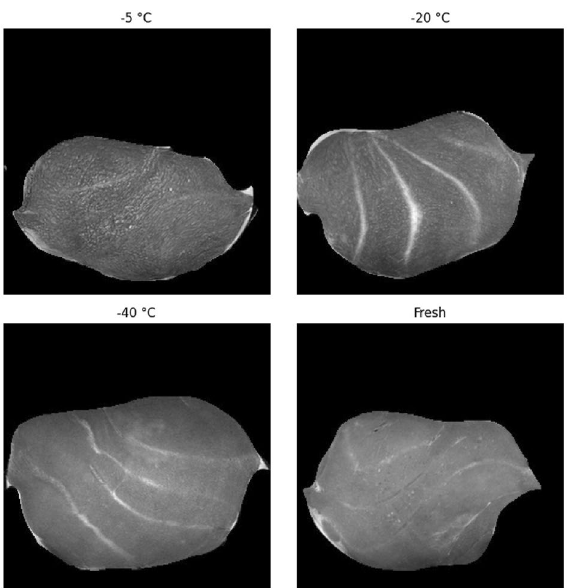
Figure 1. Examples of T 2 -weighted MRI image slices for samples that underwent a − 5 °C, − 20 °C, or − 40 °C freezing and thawing process, as well as a T 2 -weighted MRI image slice in the fresh state (i.e., obtained before freezing and